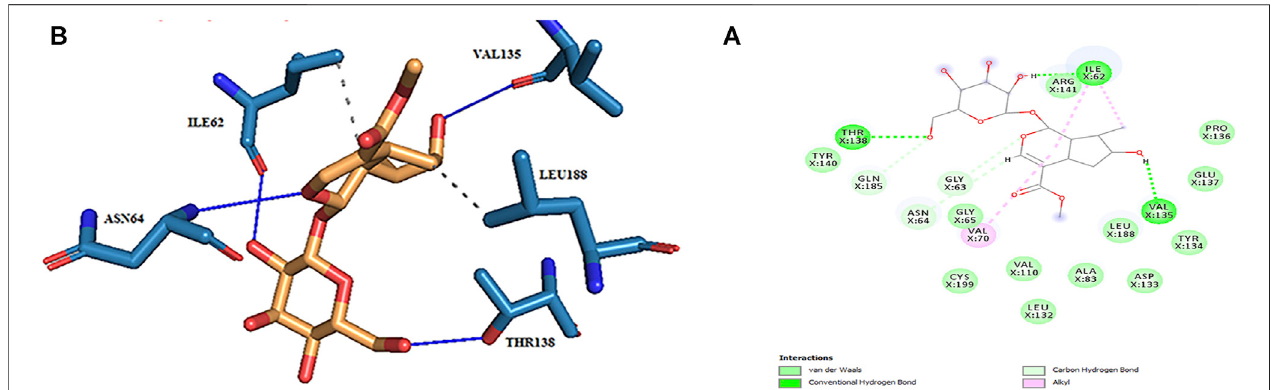
FIGURE 5 | (A) 2d and (B) 3d view of the GSK_3 β _loganin complex after MD simulation.